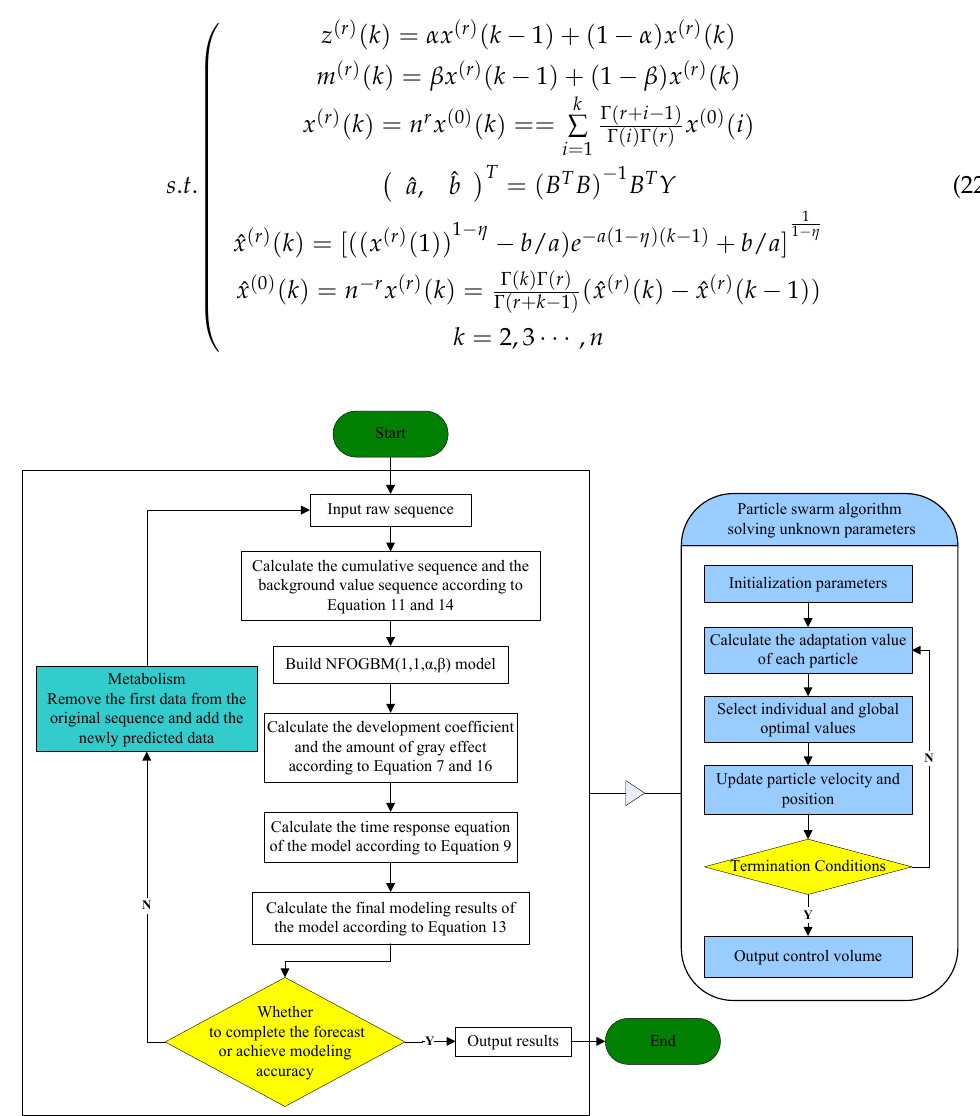
Figure 1. NFOGBM(1,1, α , β ) modeling